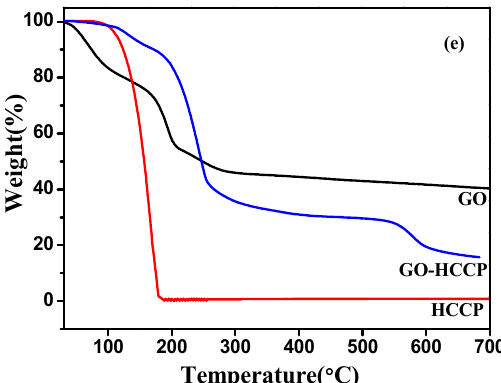
Figure 3. Molecular structure of the GO-HCCP. ( a ) FTIR (fourier transform infrared spectrometry), ( b ) XRD (X-ray diffraction), ( c ) XPS (X-ray photoelectron spectroscopy), ( d ) Raman, ( e ) TGA (thermogravimetric analysis) curve of GO, HCCP and GO-HCCP.